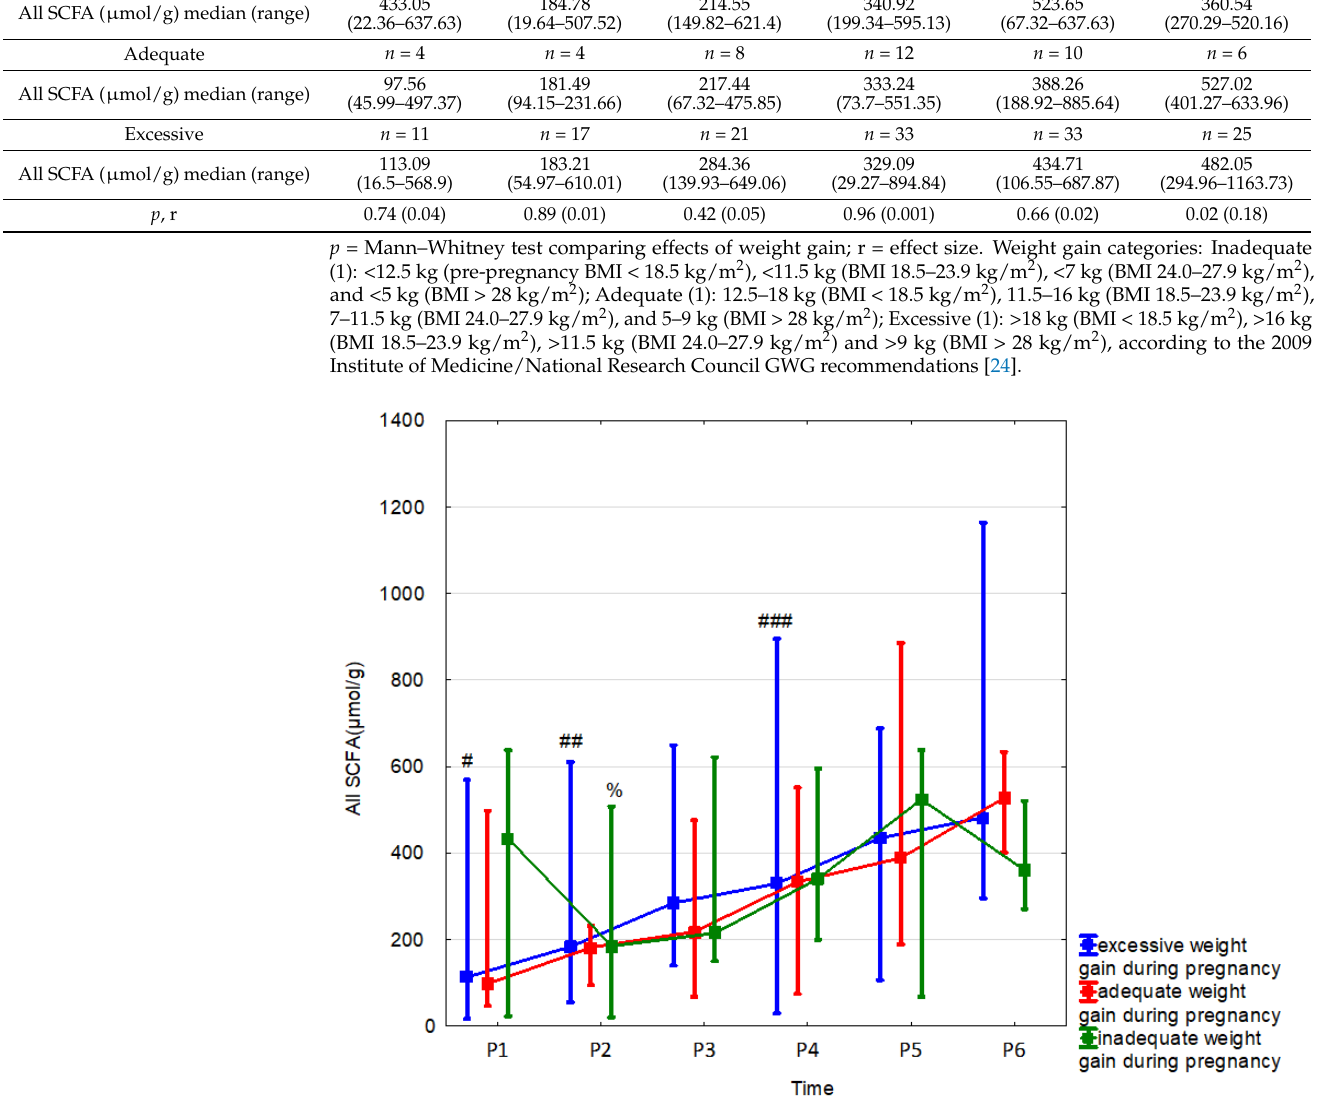
Figure 7. All SCFAs (median) in children over time according to the effects of weight gain during pregnancy. Excessive (blue line), adequate (red line) or inadequate (green line). Legend: Error bars represent range. Wilcoxon paired tests regarding time, # (excessive), $ (adequate), % (inadequate): # p < 0.05 P1 vs. P3, P4, P5 and P6; ##, %: p < 0.05 P2 vs. P3, P4, P5 and P6; ### p < 0.05 P4 vs.